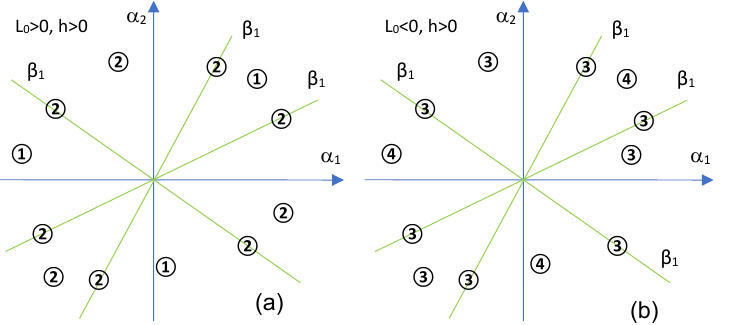
Figure 4. Bifurcation diagrams in the Case I when p < 0, r < 0, and ∆ 2 > 0: ( a ) L 0 > 0, h > 0; ( b ) L 0 < 0, h > 0.